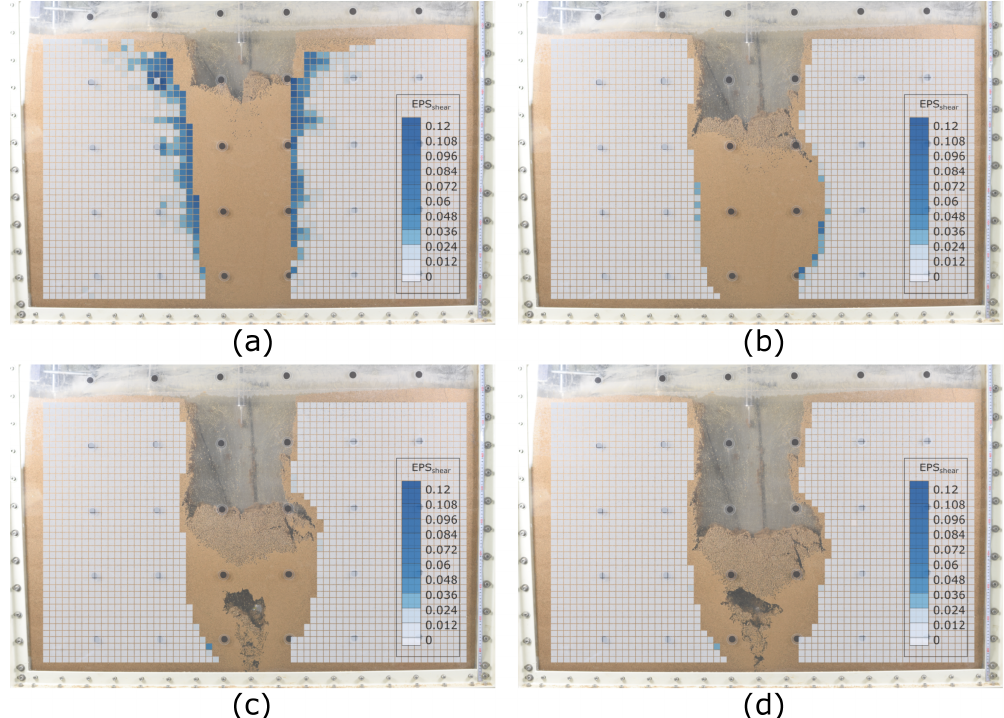
Figure 14. Shear strain inside the model ground for Test 3 during the water drainage stage: (a) 0–30s, (b) 30–60s, (c) 60–90s, and (d) 90–